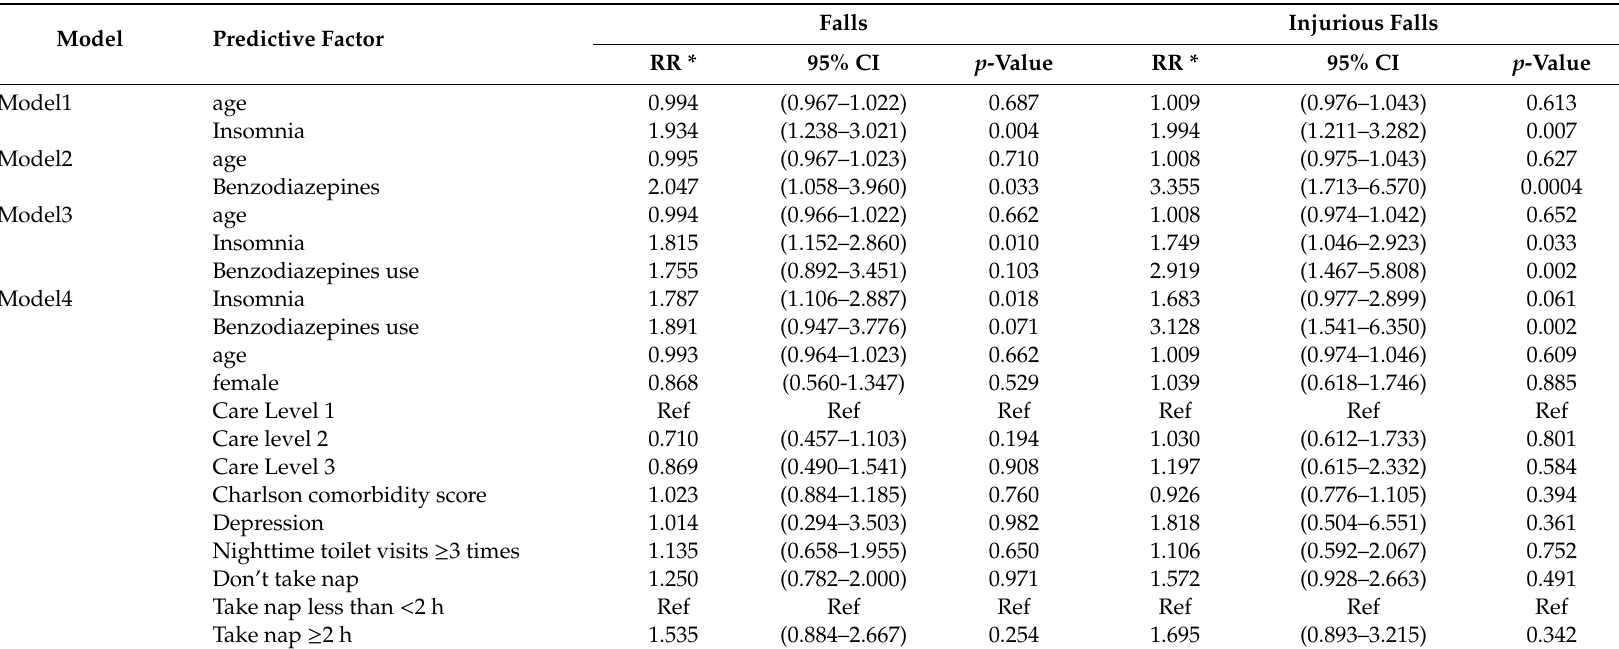
Table 3. Adjusted association of insomnia and hypnotics use with falls and injurious falls in the study participants ( n = 605).